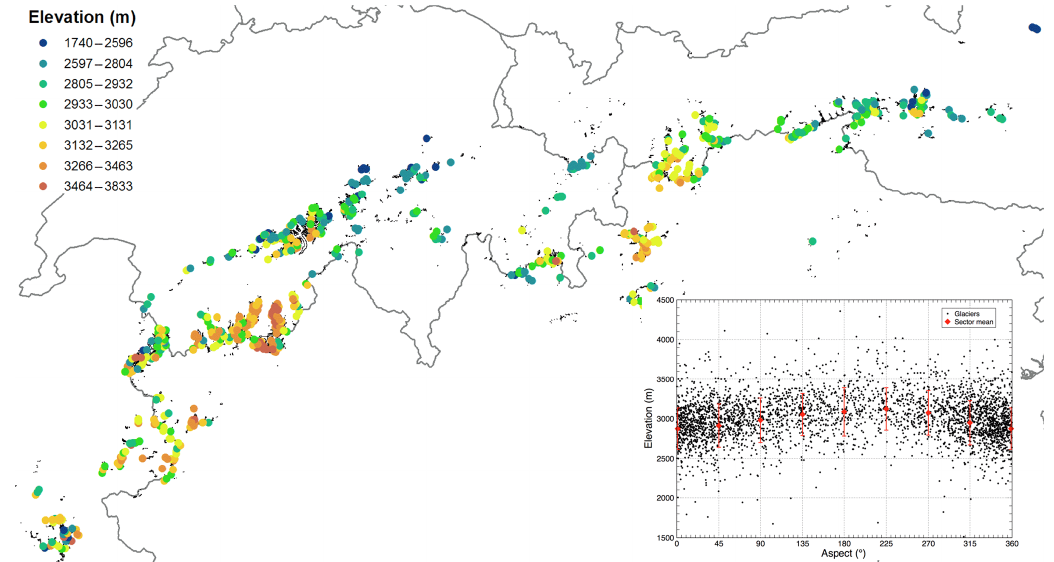
Figure 7. Spatial distribution of median elevation (colour-coded) for glaciers larger 0.5km 2 . The inset shows a scatterplot depicting glacier aspect (counted from north at 0 ◦ ) vs. median elevation and values averaged for each cardinal